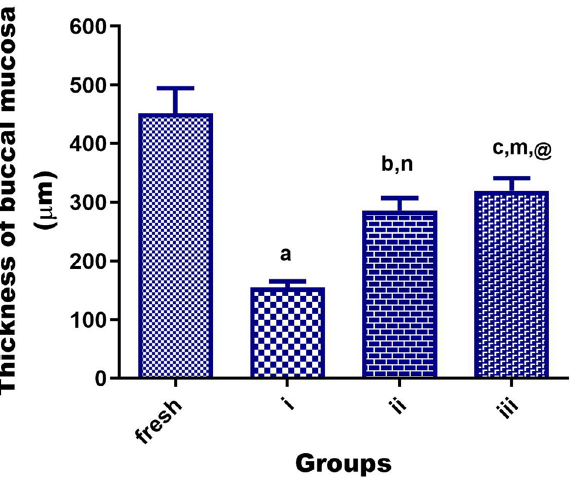
Figure 8. Statistical analysis of the thickness of H&E-stained sections of chicken cyst tissues (as buccal mucosa model) using one-way analysis of variance (ANOVA) followed by the Tukey’s for individual comparison of group means to show a significant reduction in fresh mucosa group when exposed to a pure drug of VEN group (i) , plain NFs group (ii) or medicated NFs (F 3 ) group (iii) . Notes: Different small alphabetical letters mean significant when ρ < 0.05. ( a ρ < 0.0001; b ρ < 0.001; c ρ < 0.01 versus corresponding value of a fresh group, n ρ < 0.01 versus corresponding value of VEN group, m ρ < 0.05 versus corresponding value of VEN group, @ ρ > 0.05 versus corresponding value of plain